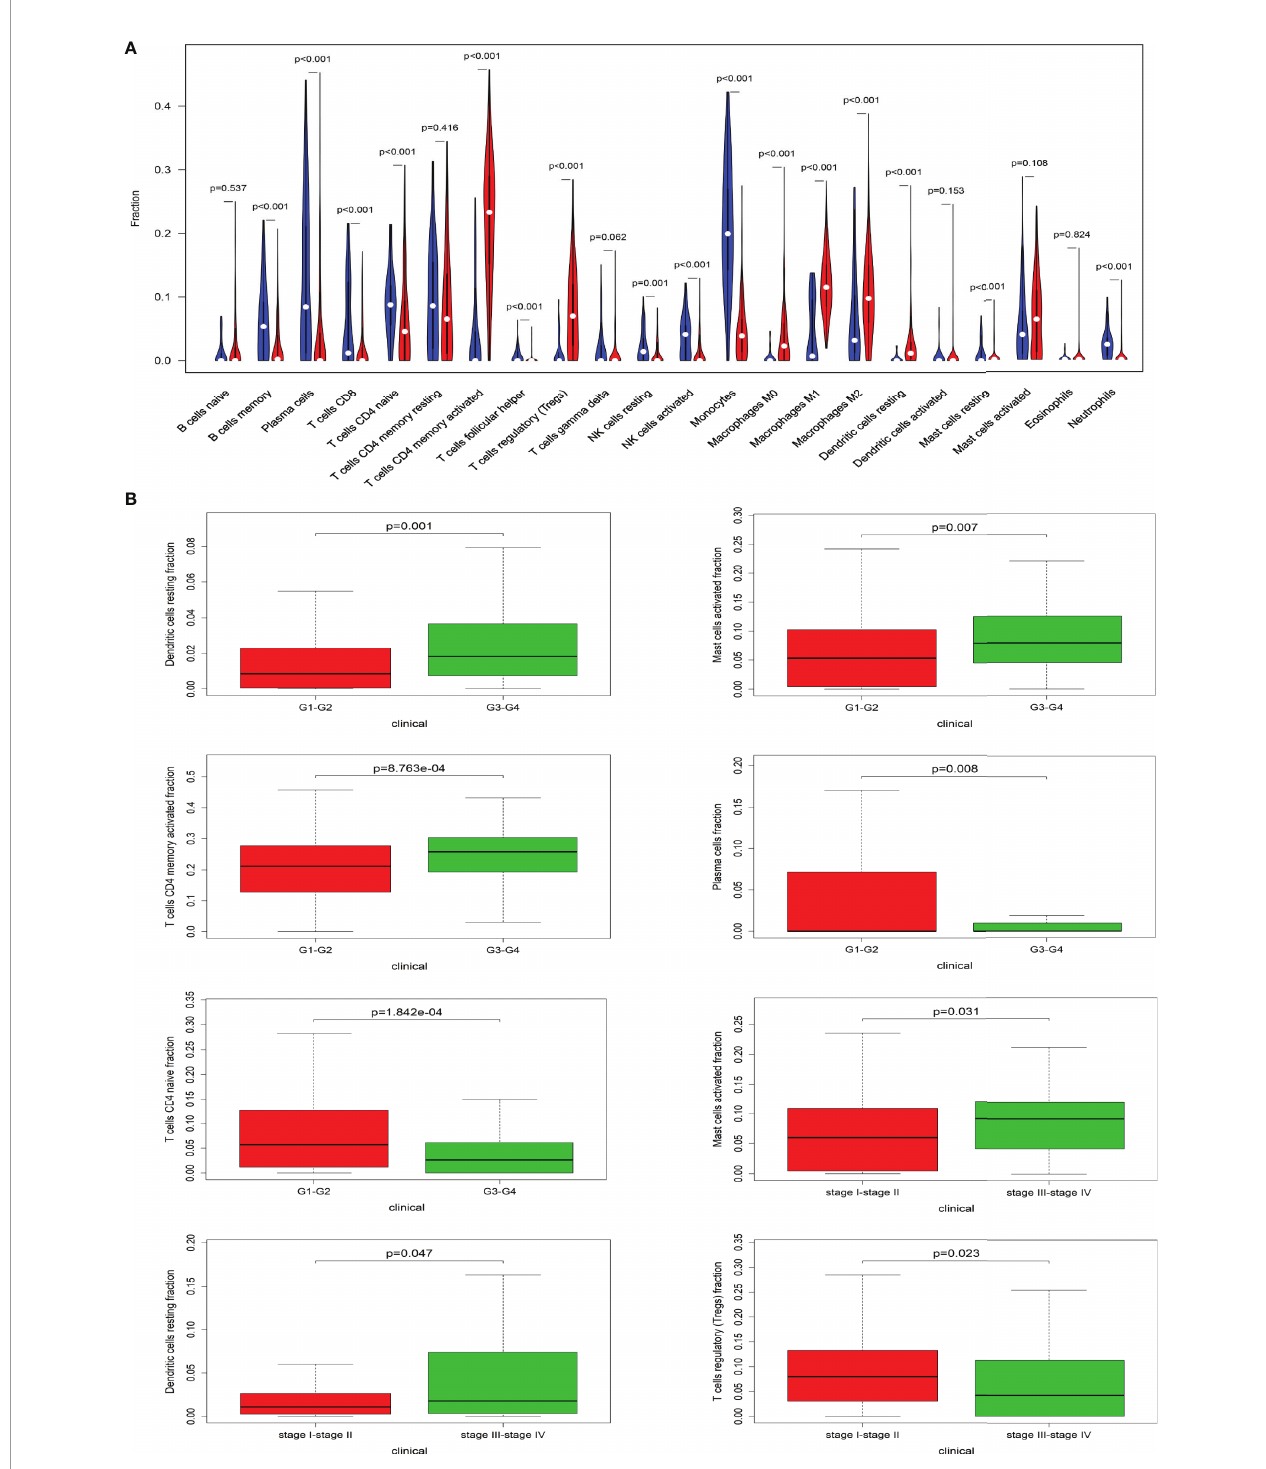
FIGURE 6 | The relationship between immune cells and clinical characteristics in HCC. (A) The differences in the composition of tumor-in fi ltrating immune cells between normal tissue and HCC tissues. CIBERSORT was employed to evaluate the compositions of immune cells in HCC and to identify immune cells related to HCC. (B) The box plots about grade and TNM stage of resting dendritic cells, activated mast cells, activated CD4 memory T cells, plasma cells, CD4 naive T cells, and regulatory T cells (P <